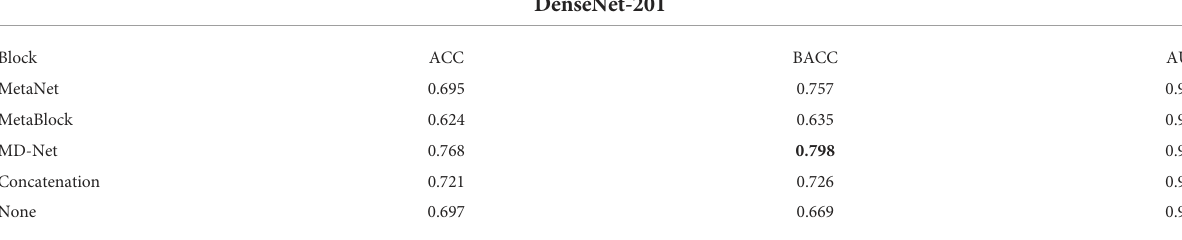
TABLE 8 Compare the performance of DenseNet-201 network fusing different modules on the PAD-UFes-20 dataset. HIGHEST AVERAGE BACC FOR EACH